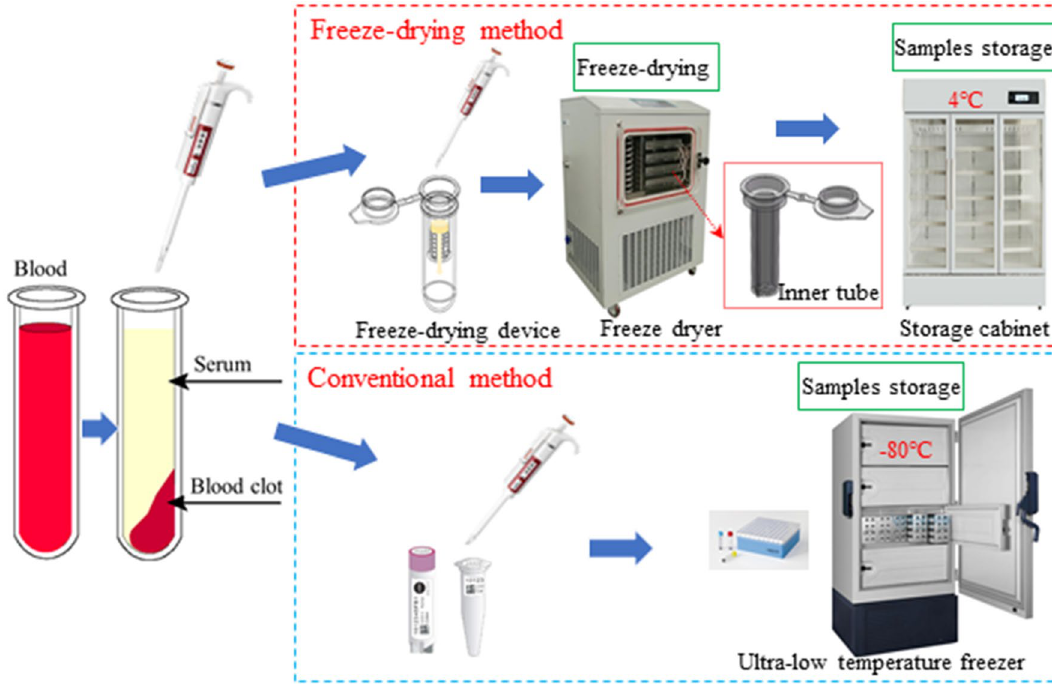
Figure 4. The serum samples were obtained after the blood was collected and maintained at 4 ℃ for 30 min. As for the freeze-drying method, serum samples were placed into the inner tube and ultrasonically blended for 5 min. The filtered sample flowed out from the inner tube and was reserved in the outer tube. The inner tube was then freeze-dried in a vacuum freeze dryer. After completing all programmed settings, the freeze-dried inner tubes were removed and eventually stored at 4 ℃ until analysis. Regarding the conventional method, the serum samples were transferred to polyethylene tubes and then stored in an ultra-low temperature freezer at – 80 °C until the time of the